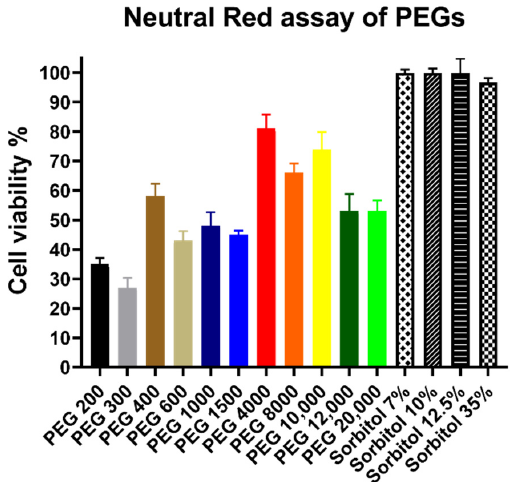
Figure 3. Cytotoxicity of PEG and sorbitol solutions measured by NR assay on Caco-2 cells. Concentrations of all PEG solutions were 30 w / v % and volumes were 100 µ L. Cell viability expressed as the percentage of the absorbance of the untreated control cells. Columns represent the mean, ± SEM, n = 10. Cell viability of the samples (mean ± SEM): PEG 200: 35% ± 2%; PEG 300: 27% ± 3%; PEG 400: 58% ± 4%; PEG 600: 43% ± 3%; PEG 1000: 48% ± 5%; PEG 1500: 45% ± 1%; PEG 4000: 81% ± 5%; PEG 8000: 66% ± 3%; PEG 10,000: 74% ± 6%; PEG 12,000: 53% ± 6%; PEG 20,000: 53% ± 4%; Sorbitol 7 w / v %: 100% ± 1%; Sorbitol 10 w / v %: 100% ± 1%; Sorbitol 12.5 w / v %: 100% ± 5%; and Sorbitol 35 w / v %: 97% ± 1%; Levels of significance after statistical analysis treated cells compared against their respec-